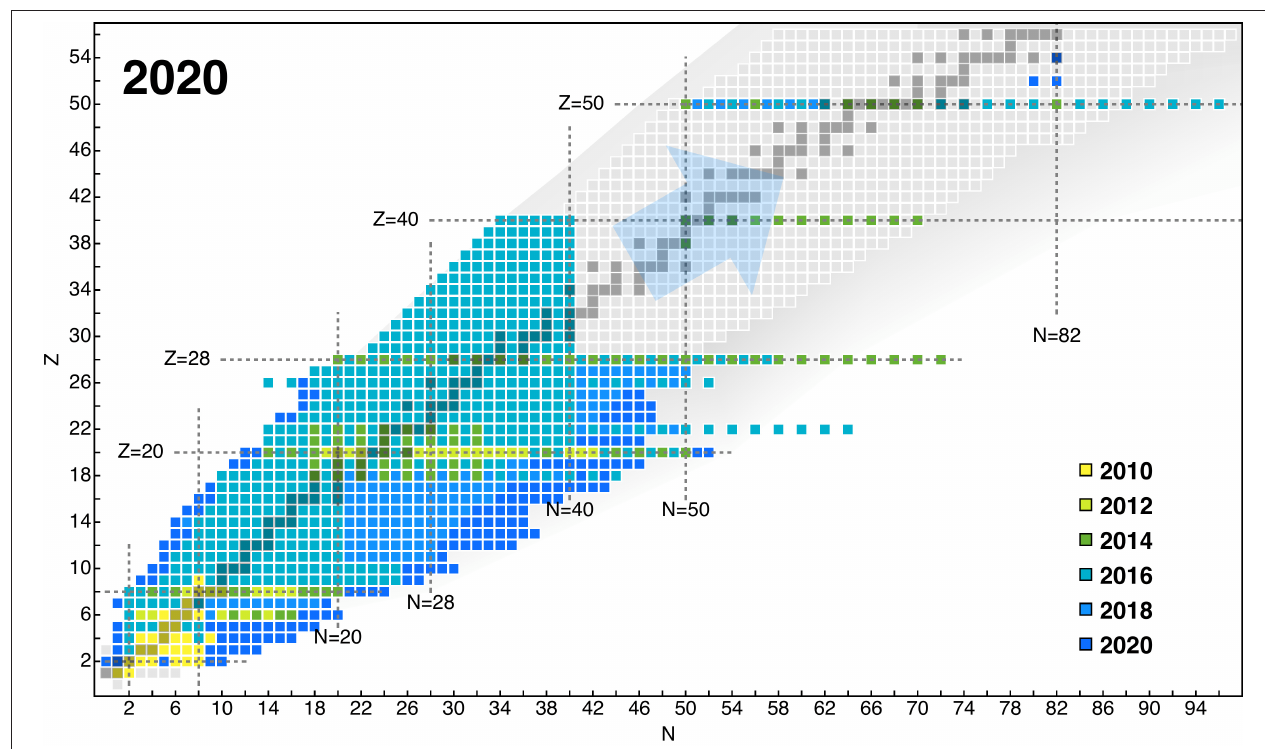
FIGURE 1 | Progress in ab initio nuclear structure calculations over the past decade. The blue arrow indicates nuclei that will become accessible with new advances for open-shell nuclei in the very near term (see section 2.3).